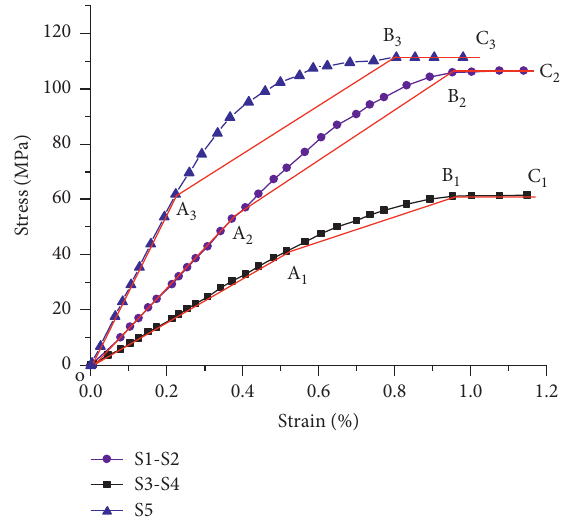
Figure 1: Multilinear kinematic